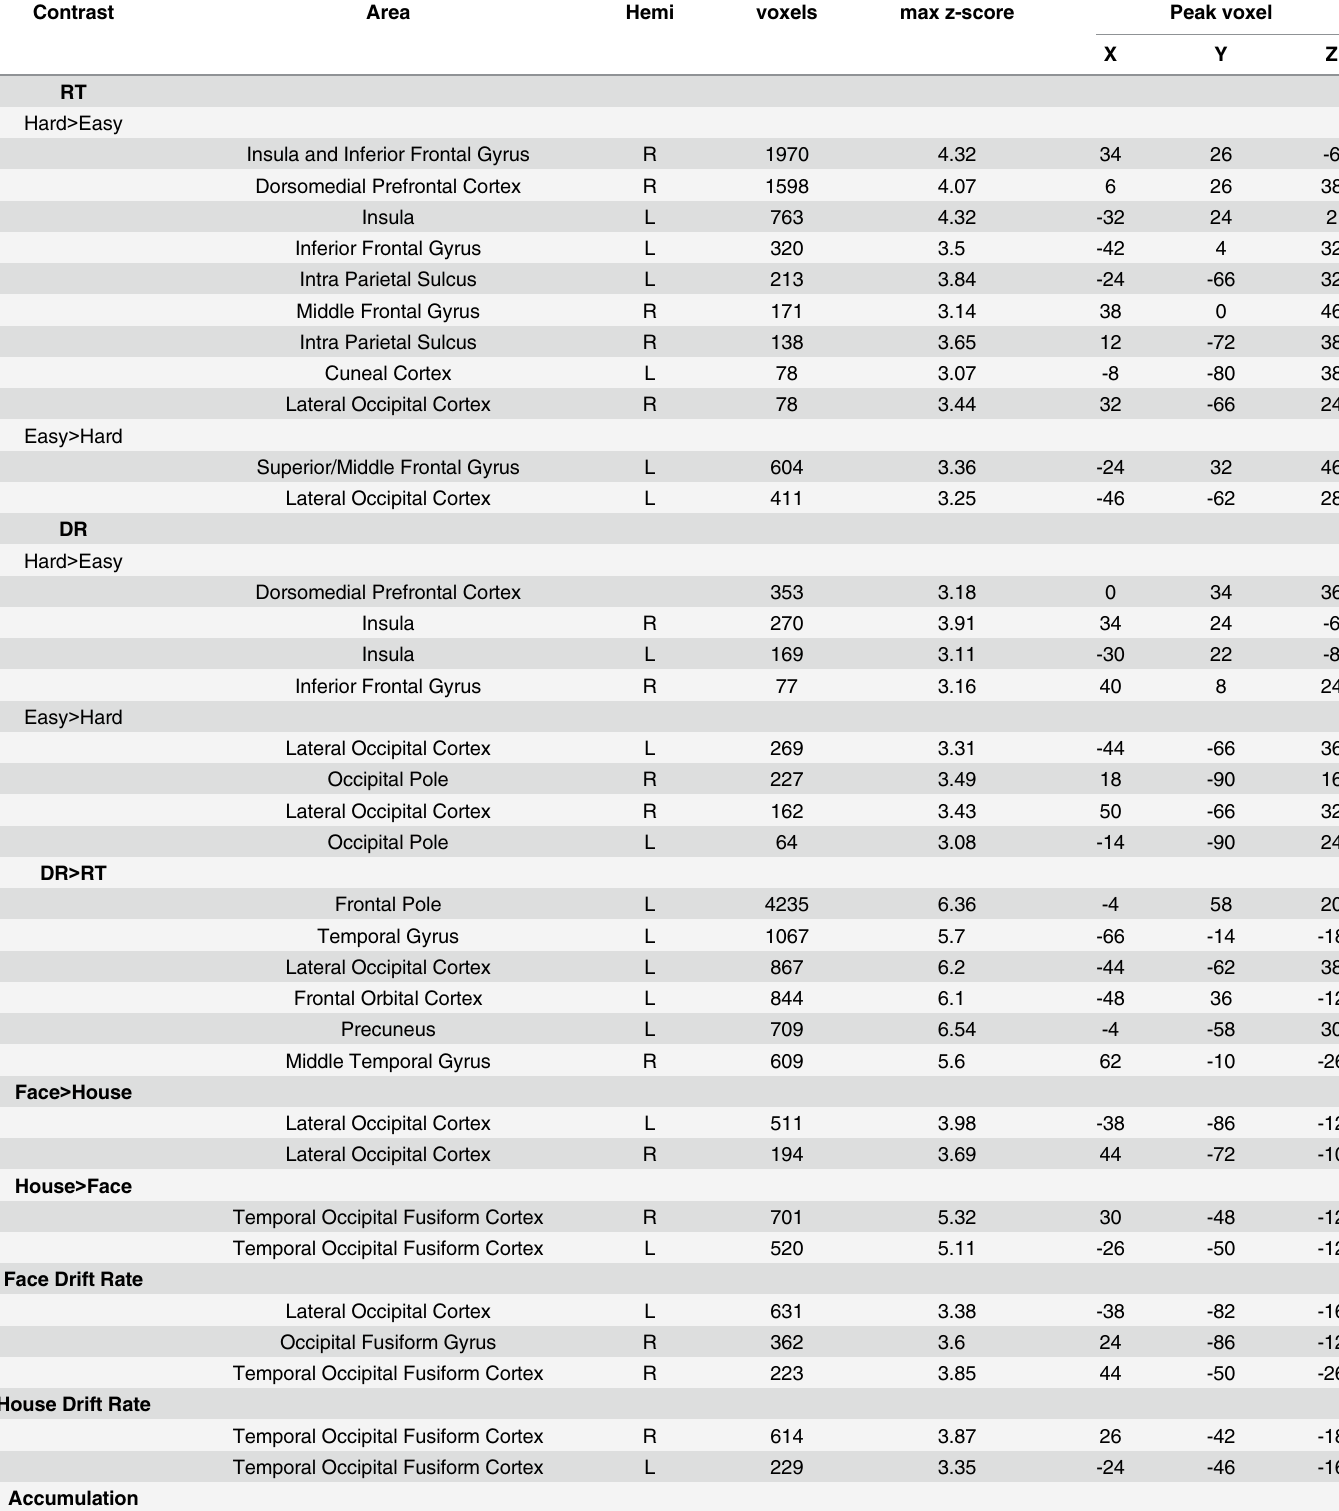
Table 1. Areas with significant activation, in MNI coordinates.